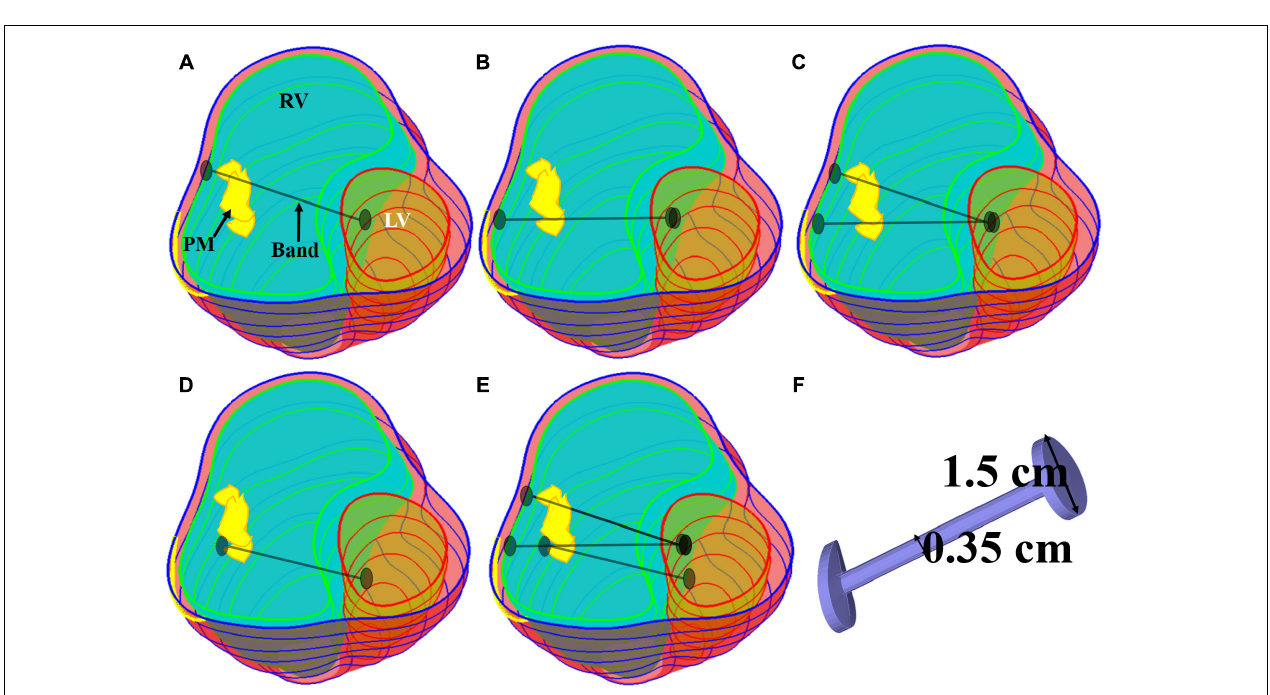
FIGURE 2 | Five band insertion surgical plans. (A) Plan A: a band at anterior to the middle of papillary muscle (PM). (B) Plan B: a band at posterior to the middle of PM. (C) Plan C: double bands, plans A and B combined. (D) Plan D: a band at the base of the PM. (E) Plan E: combination of plans C and D. (F) Inserted band. PM, papillary muscle (Yu et al.,